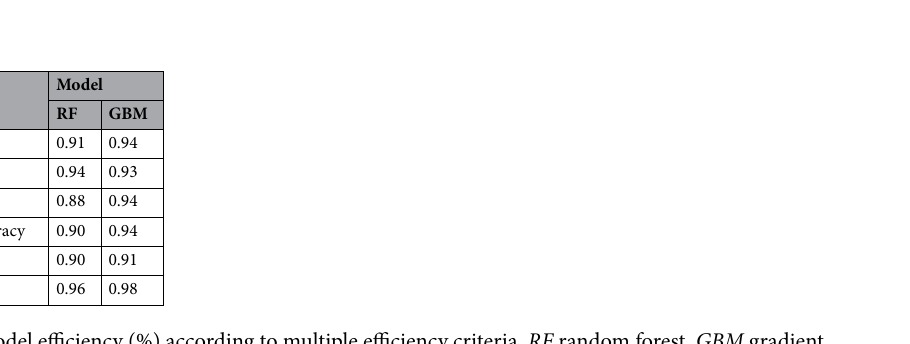
Table 2. Model efficiency (%) according to multiple efficiency criteria. RF random forest, GBM gradient boosted machine, AUC area under the curve, ROC receiver operator